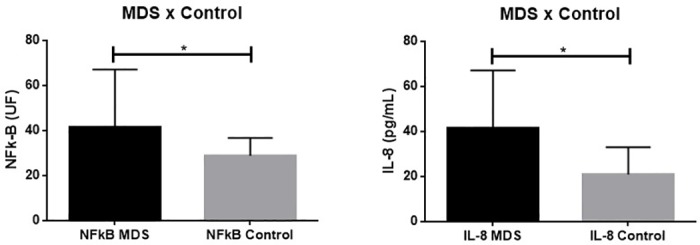
Comparison between NF-kB and IL-8 between MDS patients and controls.*p<0.05.